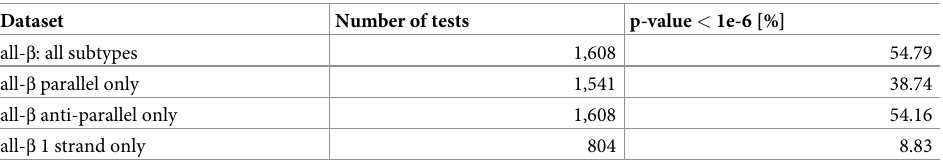
Table 3. Results of the Kolmogorov-Smirnov test applied to the all- β dataset.